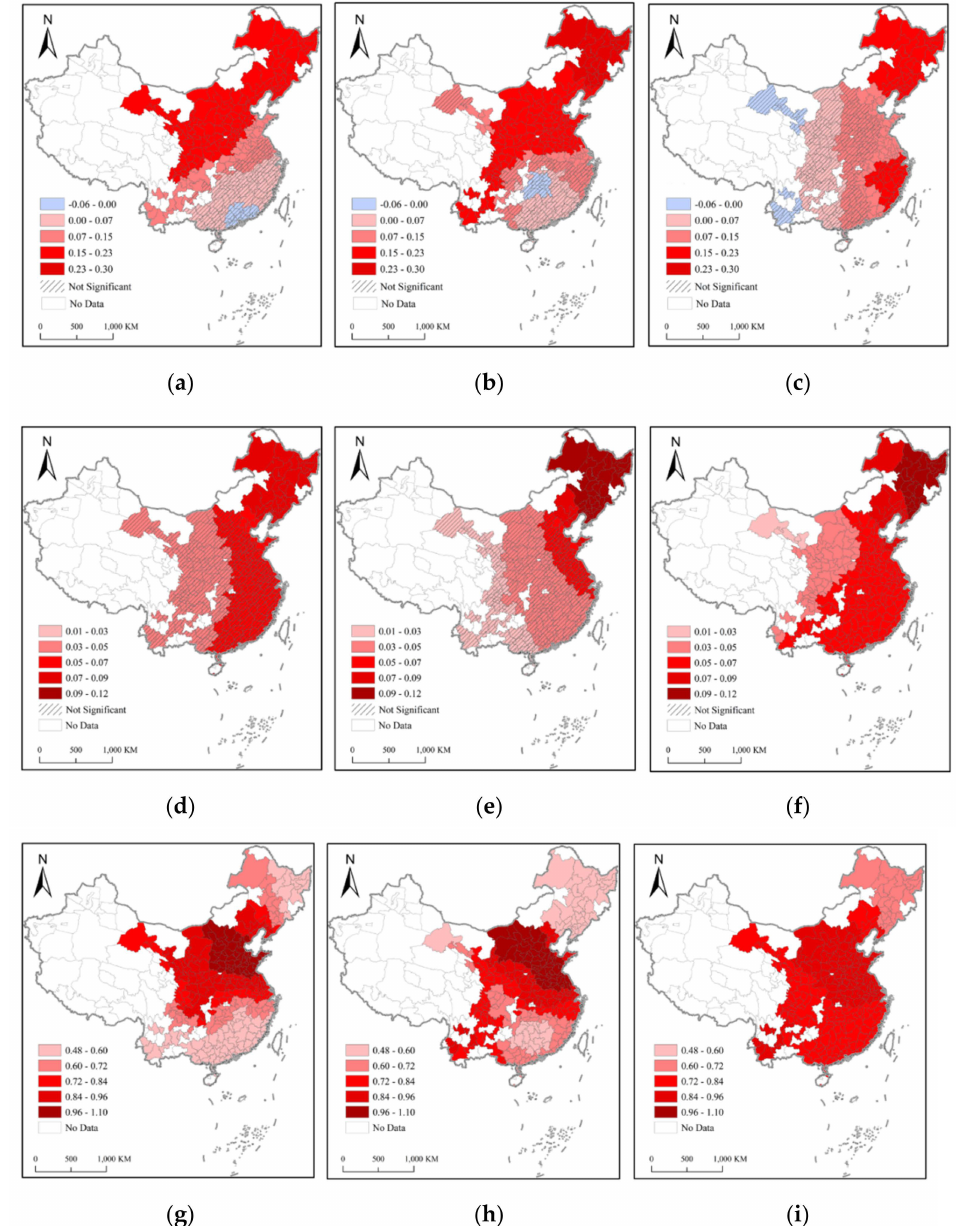
Figure 9. Spatial distribution of local parameter estimates: ( a ) 201612-popd; ( b ) 201701-popd; ( c ) 201702-popd; ( d ) 201612-scgdp; ( e ) 201701-scgdp; ( f ) 201702-scgdp; ( g ) 201612-stlag; ( h ) 201701- stlag; ( i )